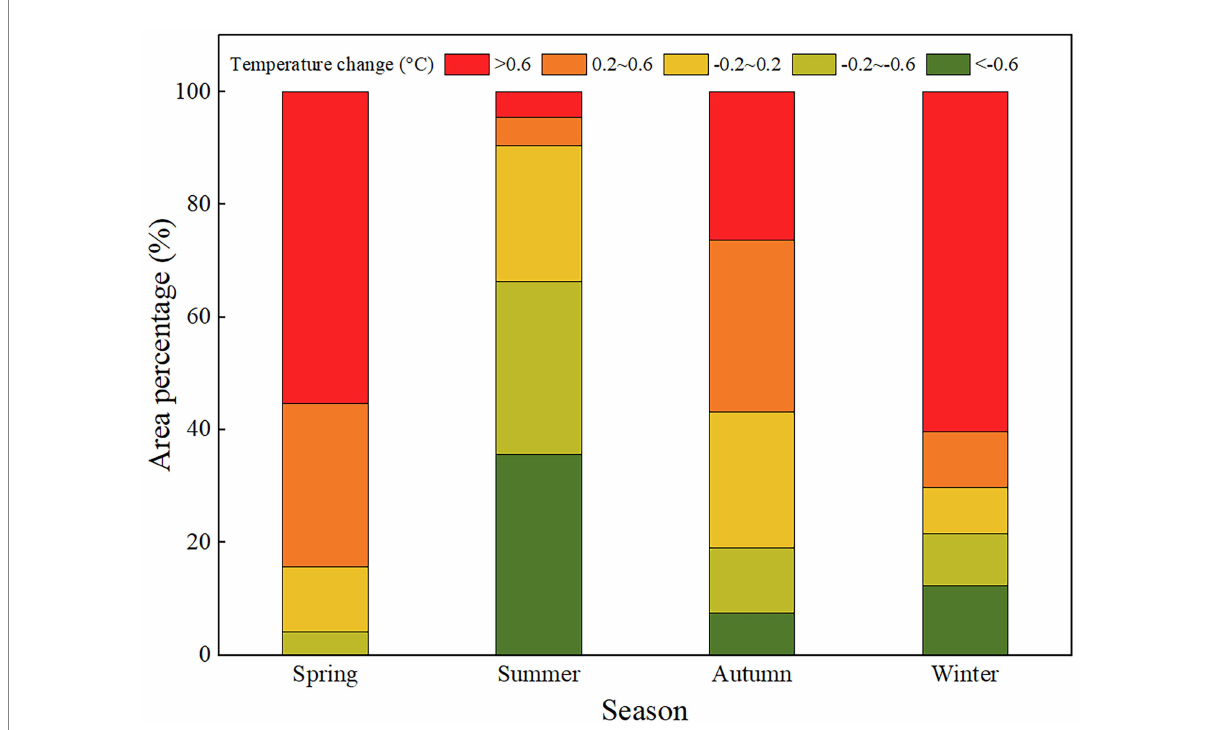
FIGURE 6 Climate change observations of 22 years of marsh area reveal a significant difference with season and